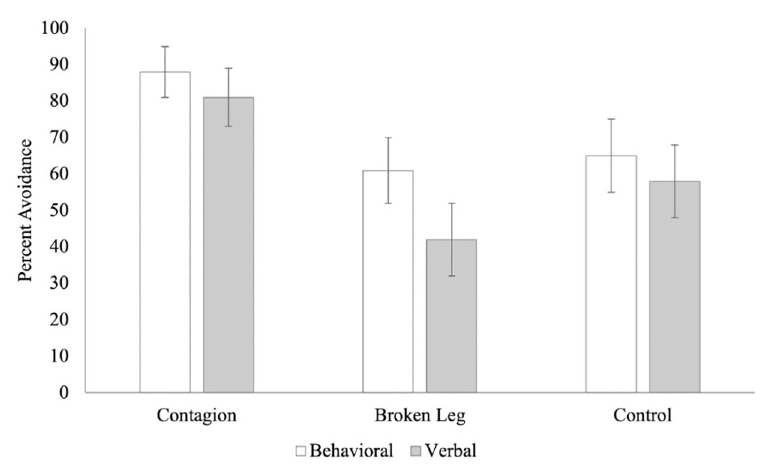
Fig 2. The Percentage of adults who avoided the target confederate in Experiment